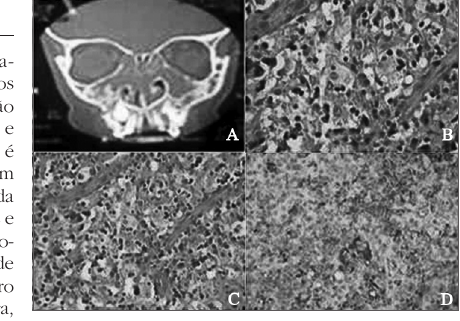
Figura 1. (a) Tomografia dos seios da face: preenchimento por partes moles de seios etmoidais e maxilares com espessamento ósseo irregular em paredes de maxilares; (b) e (c) Numerosos histiócitos grandes com citoplasma eosinofílico (20X ou 40X); (d) Achados imunohistoquímicos mostraram que a maioria dos histiócitos marcaram positivamente para